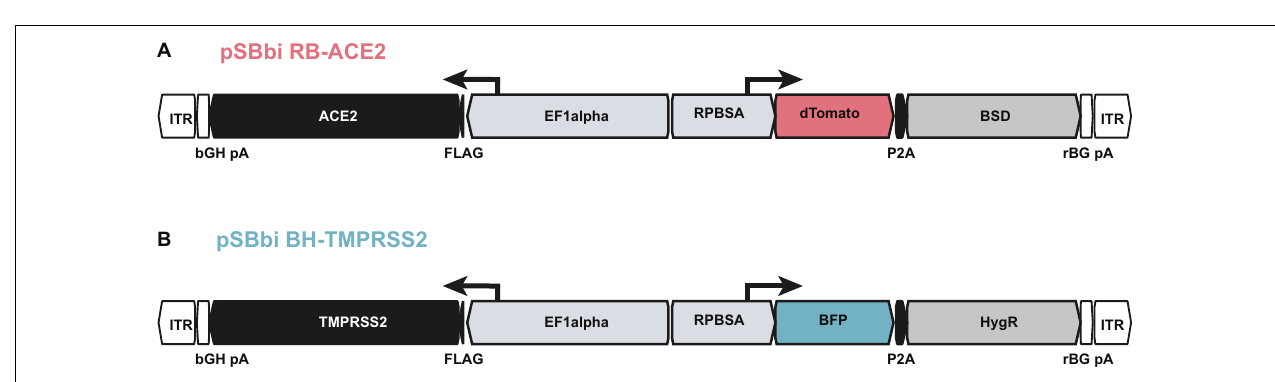
FIGURE 2 | Cell culture characteristics of A549 and Caco2 cells. (A) Growth curves of Caco2 and A549 cells were shown in 12-well plates with low density (2 × 10 4 A549-AT/well; 1 × 10 5 Caco2/well). The relative confluence was monitored automatically using live cell imaging SparkCyto 400 (Tecan) over a period of 198 h. After 48 h, each well was washed with PBS to remove unattached cells. (B) Trypsinization properties of A549 and Caco2 cells. Cells were seeded in 96-well plates, treated with trypsin/EDTA and incubated for the indicated time. For incubation times longer than 10 min cells were incubated at 37 ◦ C, otherwise at room temperature. (C,D) To determine transfection efficiency, A549 and Caco2 cells were transiently transfected with an eGFP-encoding plasmid (pSBtet GP). After 48 h, eGFP fluorescence was detected. (D) DAPI normalized green object count of Caco2 and A549 cells 24 and 48 h post transfection. Error bars indicate SD from three biological replicates. * p < 0.05, ** p ≤ 0.01, and *** p ≤ 0.001.